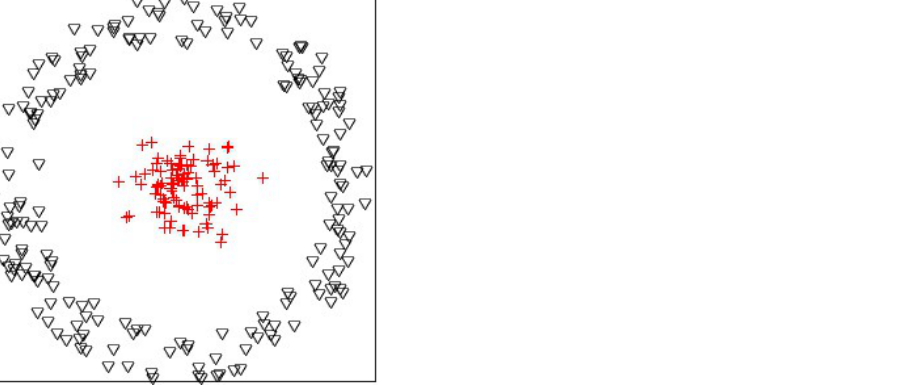
Figure 2. The synthetic dataset, which is composed of two linearly inseparable classes: disc and ring.